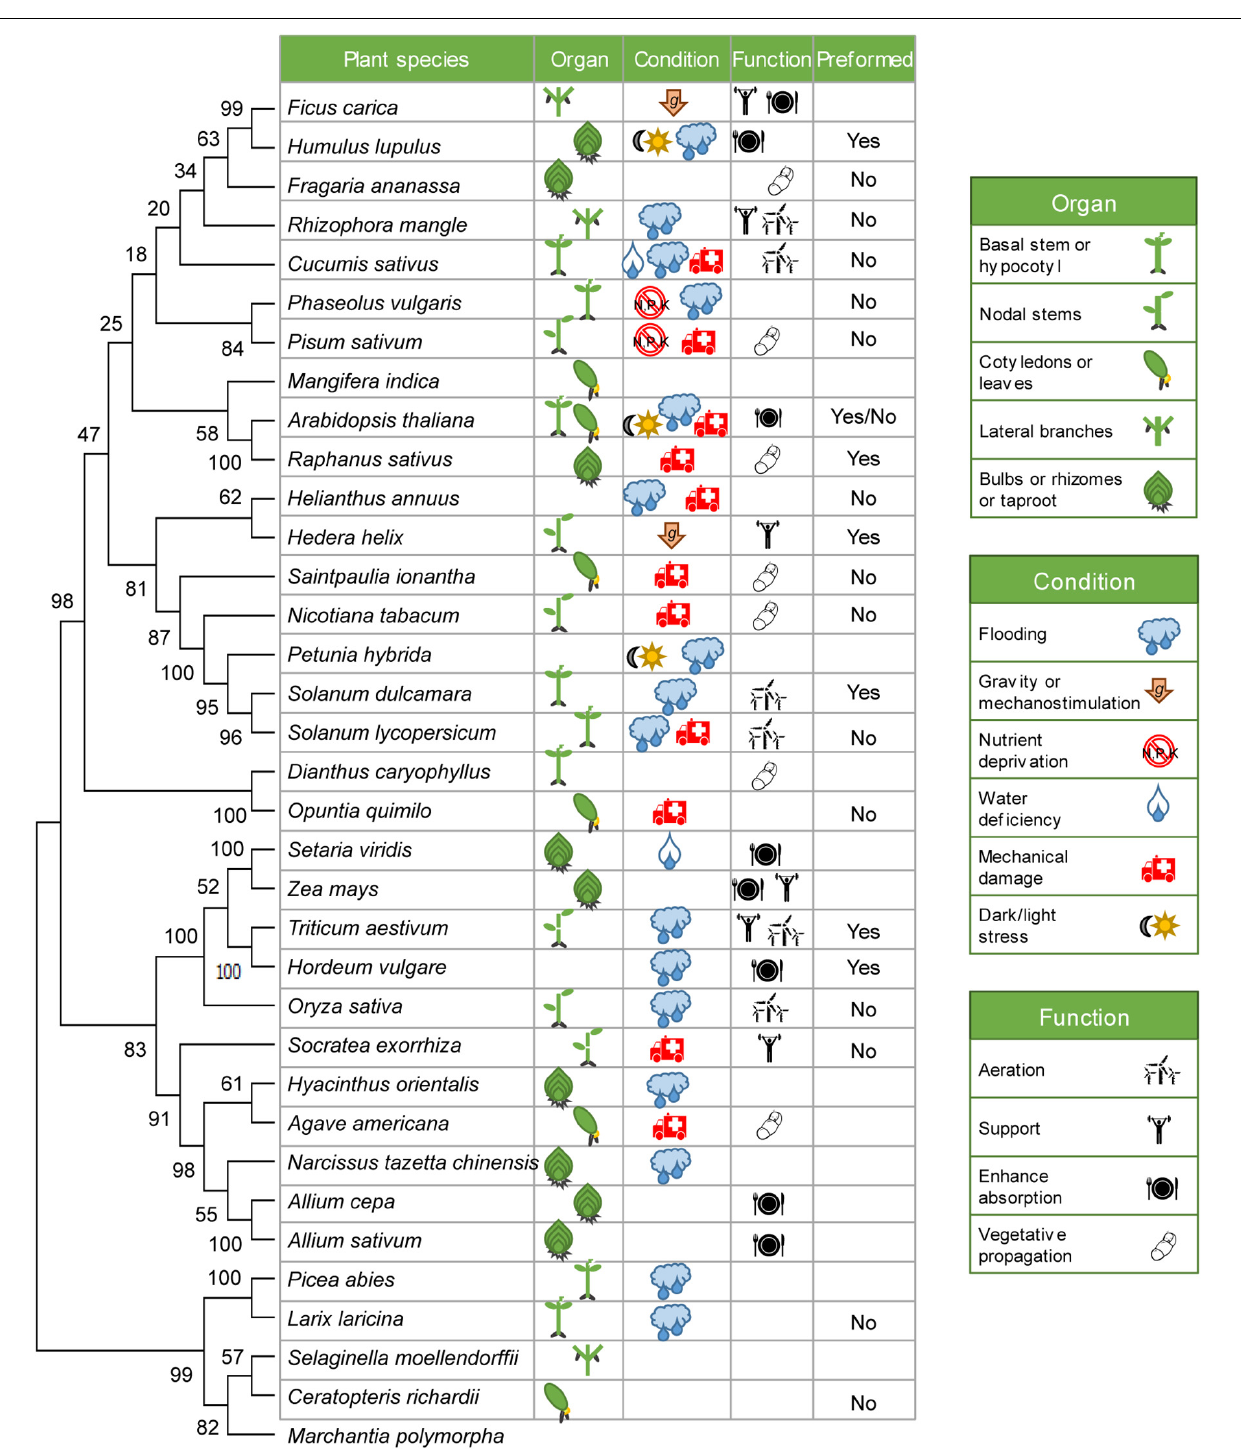
Frontiers in Plant Science |